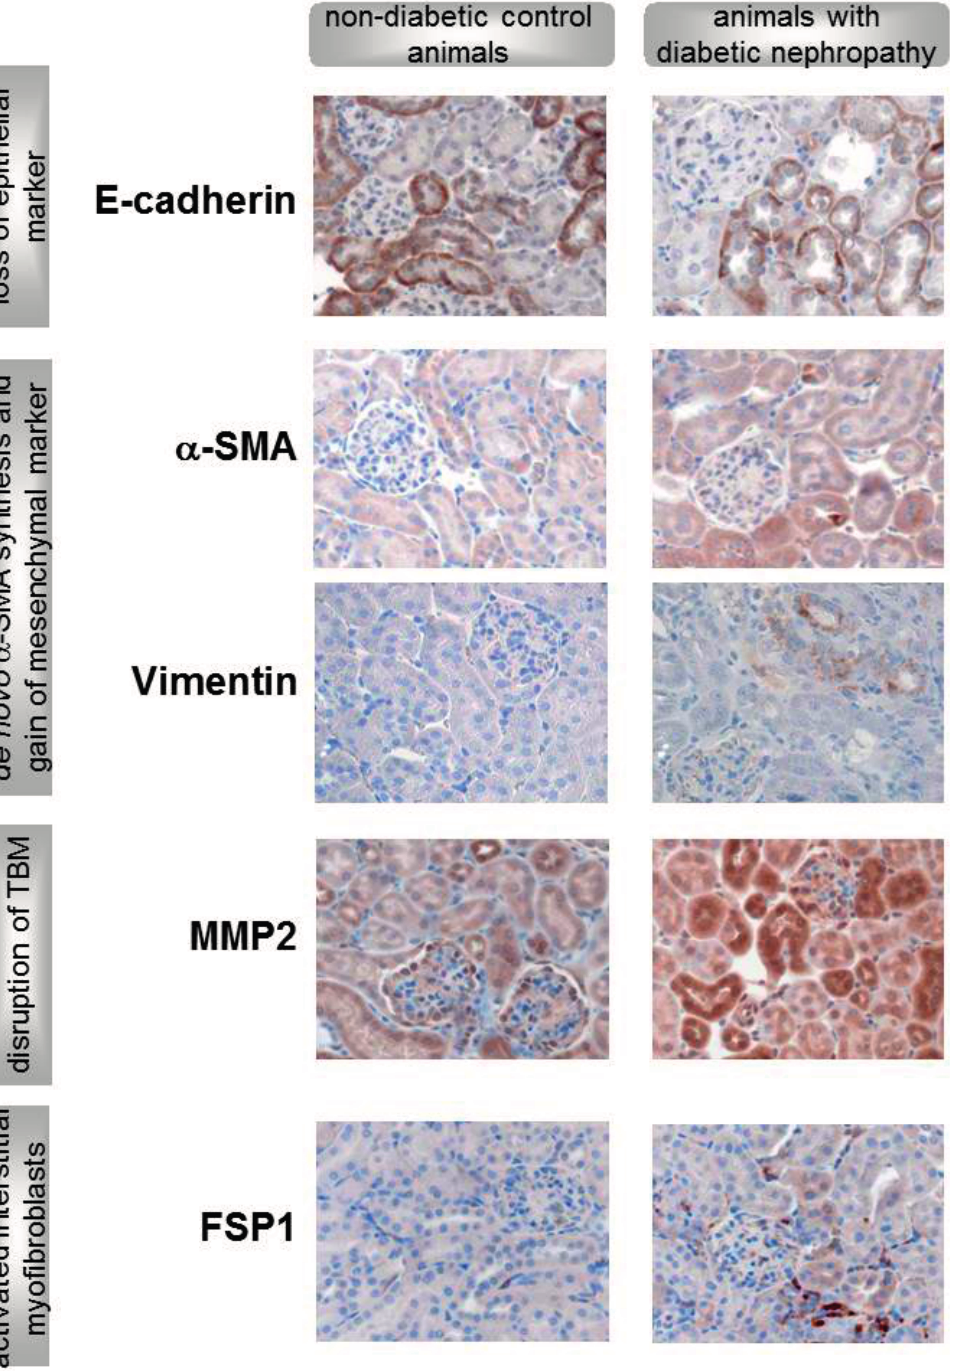
Figure 2. Evidence for tubular EMT in streptozotocin (STZ)-induced diabetic mice (unpublished data from the authors’ laboratory). Shown are representative immunhistochemical stainings reflecting the four key events of EMT leading to activated interstitial myofibroblasts: (1) reduction of epithelial marker (e.g. E-cadherin), (2) de novo α -SMA synthesis and increased expression of mesenchymal marker (e.g. vimentin), (3) disruption of tubular basement membrane (TBM) by matrix metalloproteinases (e.g. MMP2), and (4) invasion of activated myofibroblasts into the interstitium (FSP1 positive cells). Magnification